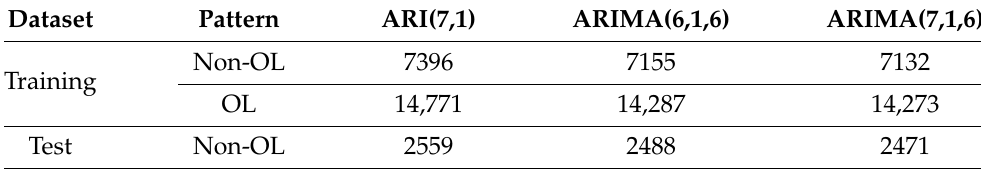
Table 4. The number of feature–label pairs generated by different models.